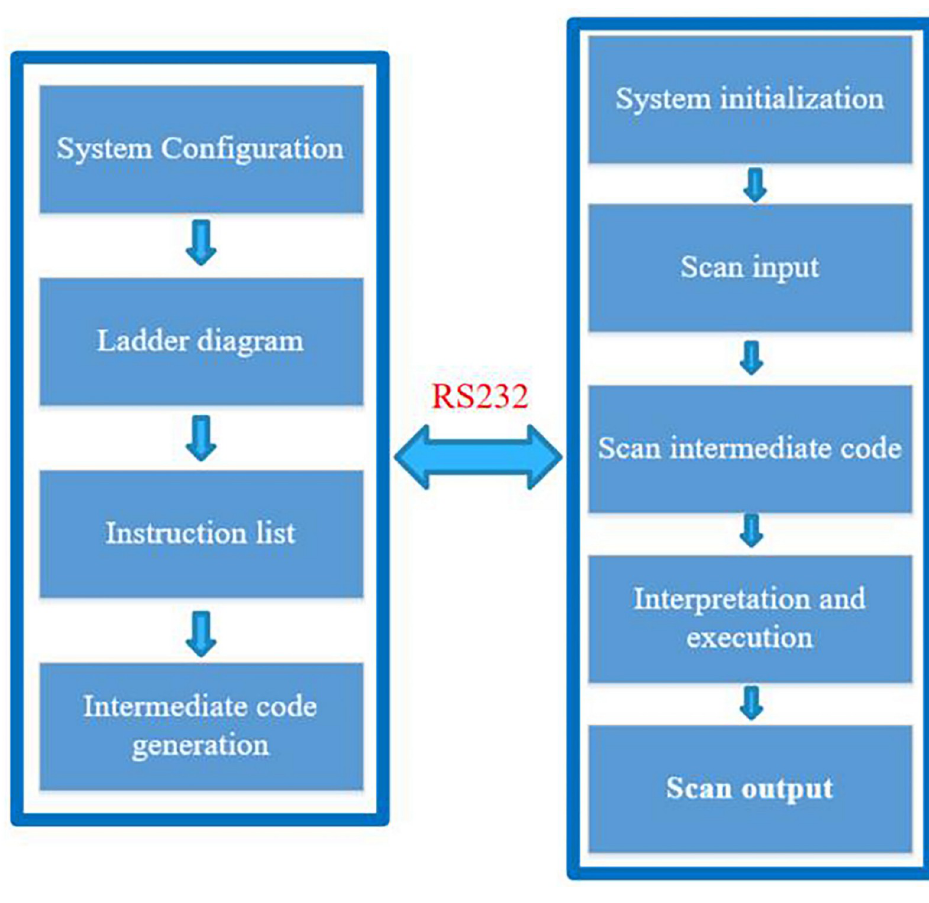
Fig 7. Interpretation type PLC overall structure.